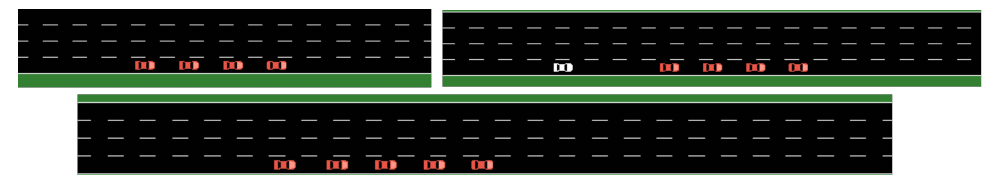
Figure 7. Joining maneuver.